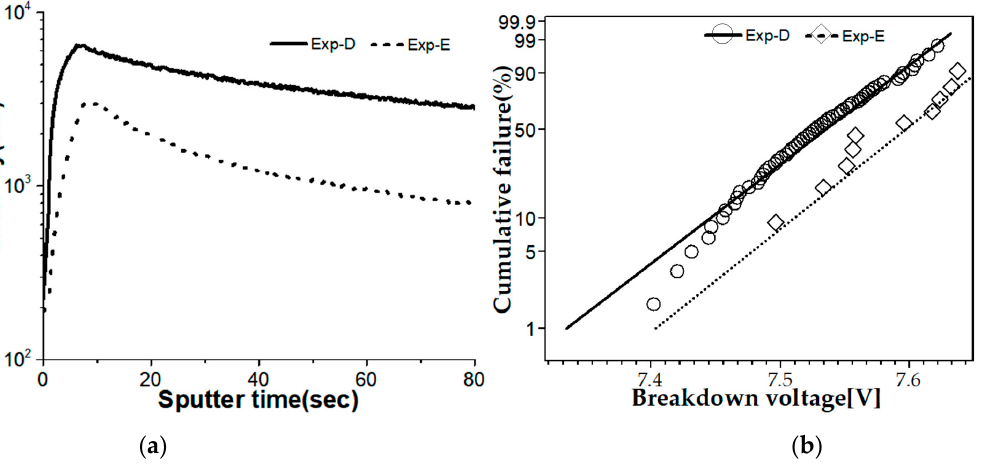
Figure 8. ( a ) Carbon counts of TOF-SIMS and ( b ) Weibull distribution curves for breakdown voltage for Exp-D and E.